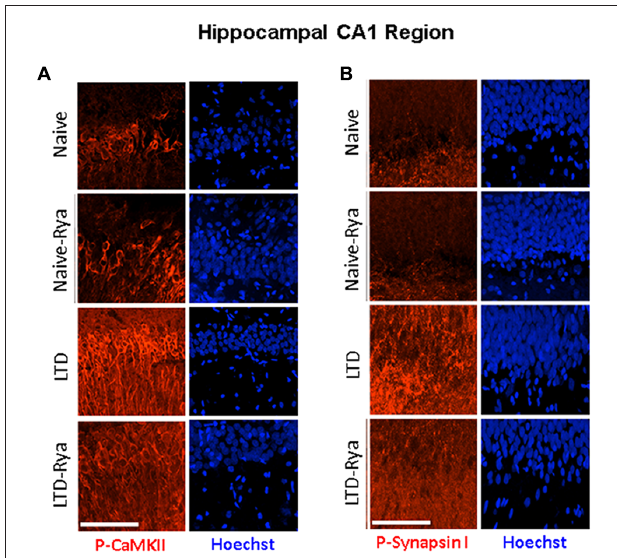
FIGURE 6 | The LTD induction protocol increased (A) CaMKII and (B) Synapsin I phosphorylation levels in hippocampal sections. The figure illustrates representative immunohistochemistry images. (A) CA1-containing hippocampal section stained with an antibody against phospho-CaMKII or (B) with an antibody against phospho-Synapsin-I, which detects CaMKII- dependent phosphorylation of phospho-Ser-603. Three independent experiments yielded similar results. For experimental details, see text. The calibration bar represents 50 µ